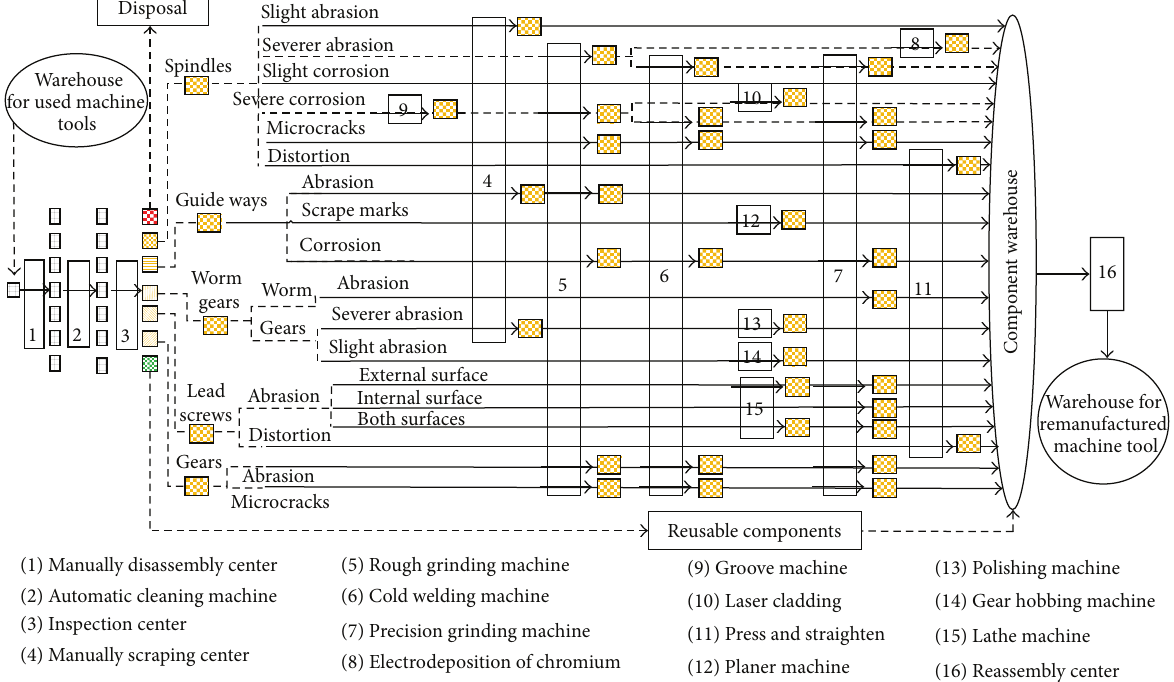
Figure 1: The remanufacturing process routings of machine tool